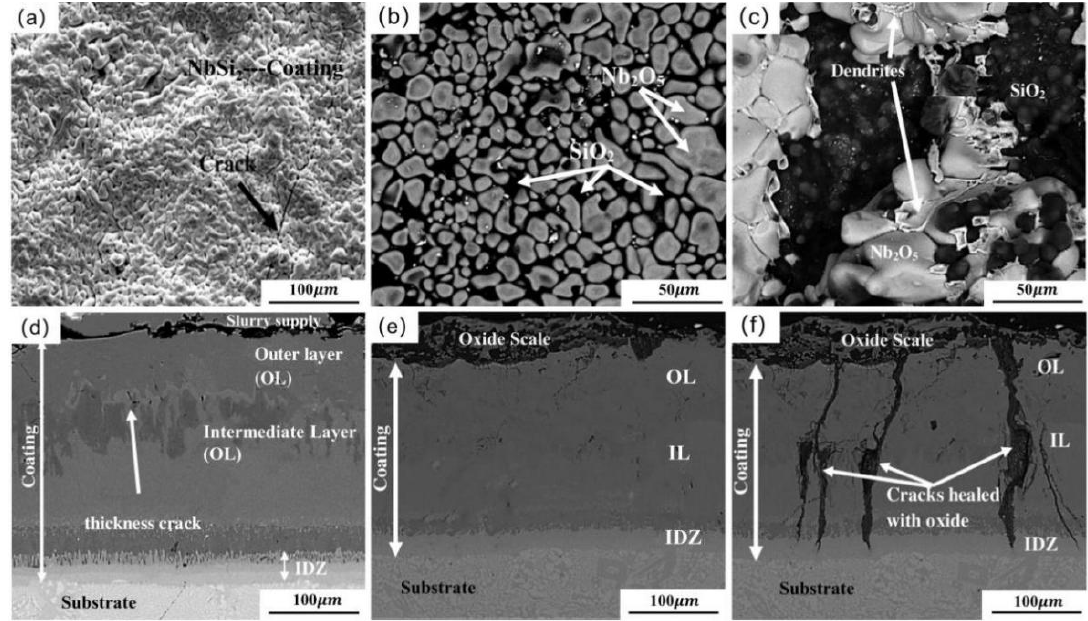
Figure 3. SEM images of SS coating before and after oxidation: ( a , d ) Before oxidation; ( b , e ) After oxidation for 2 h; ( c , f ) Coating morphologies after oxidation failure.